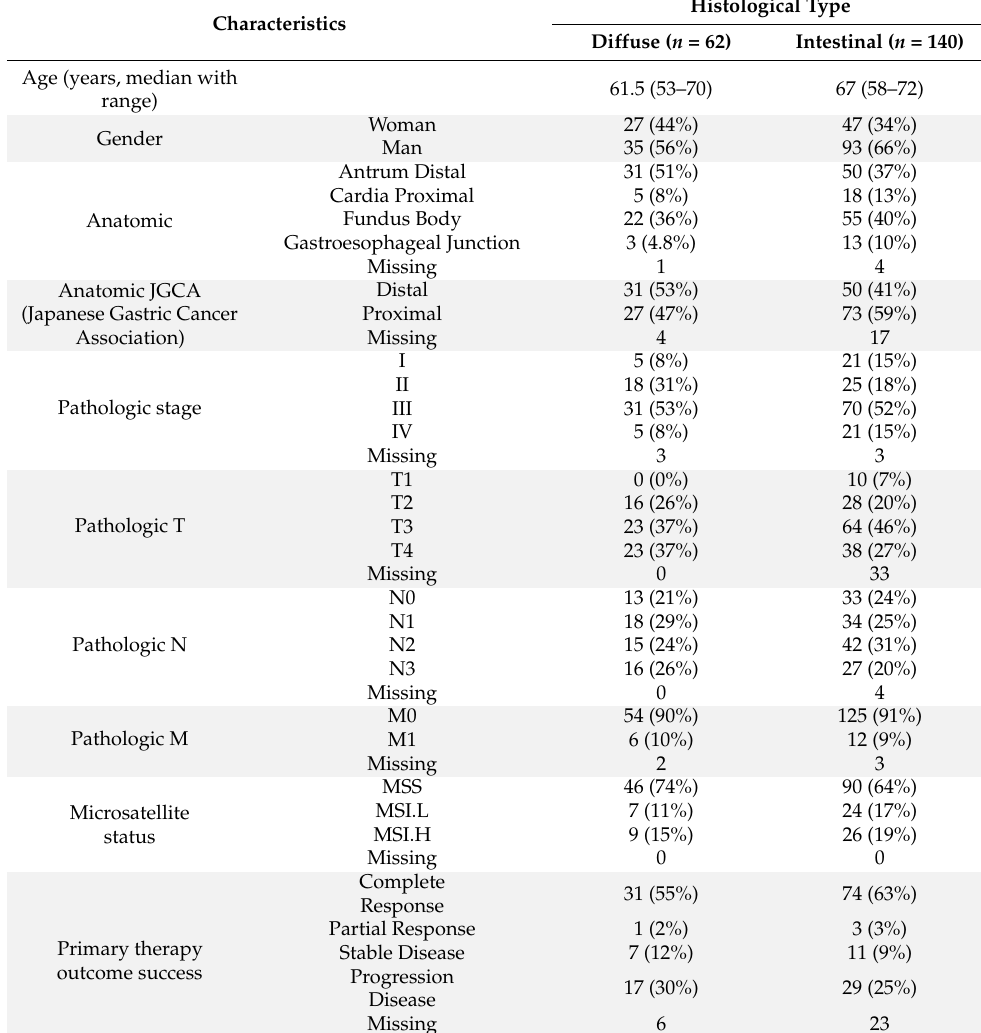
Table 1. Patient characteristics and clinicopathological